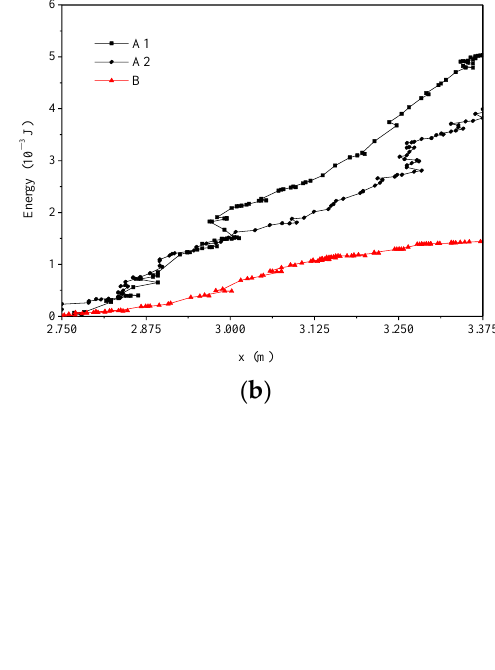
Figure 7. The drag force and the magnitude of fish under three typical hydraulic conditions: ( a ) high velocity zone, ( b ) high TKE zone and ( c ) high SR zone (Note: the black trajectories represent fish passing through high V (trajectories A1V, A2V), TKE (trajectories A1T, A2T) and SR (trajectories A1S, A2S) zones, the red trajectory represents fish not passing through the above-mentioned high zones).